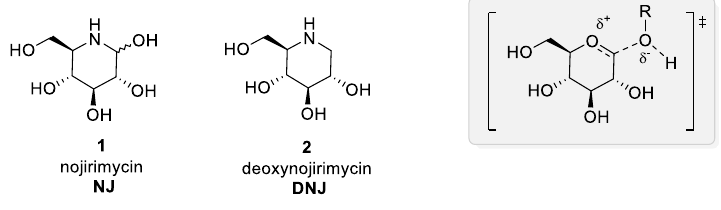
Figure 2. Iminosugars: carbohydrate mimetics.